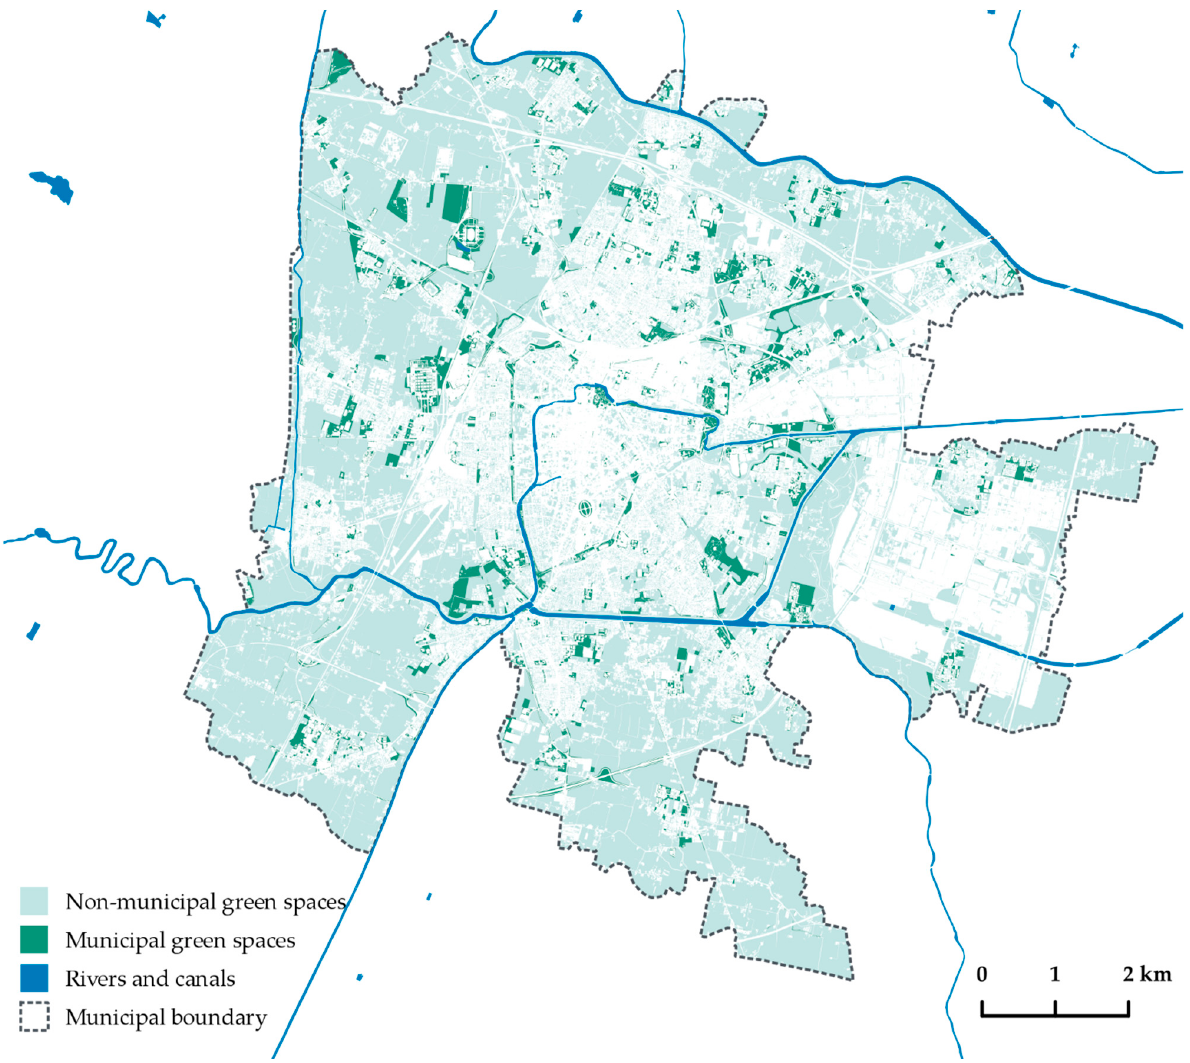
Figure 10. Map of public urban green spaces: municipal green spaces (light green), non-municipal green spaces (green). Table 10. Matrix of public–private and rural–non-rural green